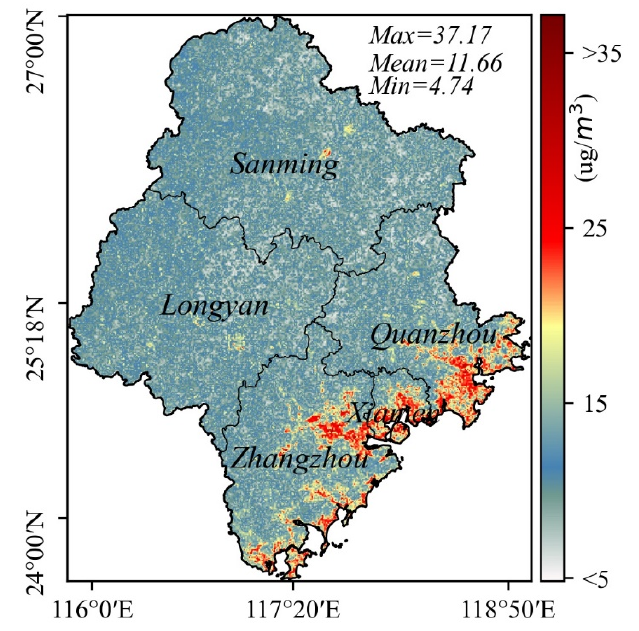
Figure 8. Annual average distribution of NO 2 concentrations in SWFJ in 2018. Mean, Max and Min represent the average, maximum, and minimum of monthly average pixels, respectively. The red highlighted region represents the NO 2 concentration high value, and the blue part represents the NO 2 concentration low value. The color bar on the right represents the NO 2 concentration.